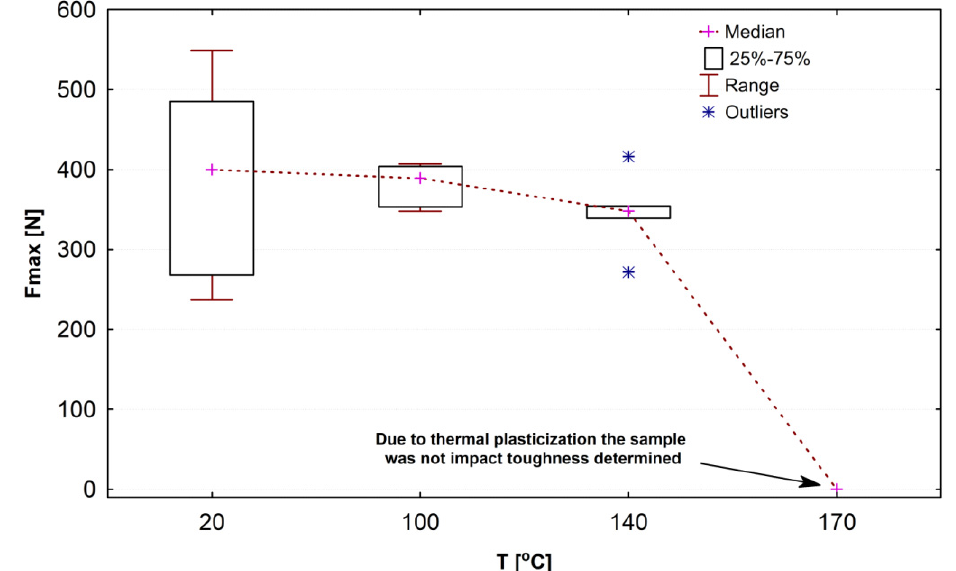
Figure 9. Framing chart presenting results of a bending strength test with a thermal shock.